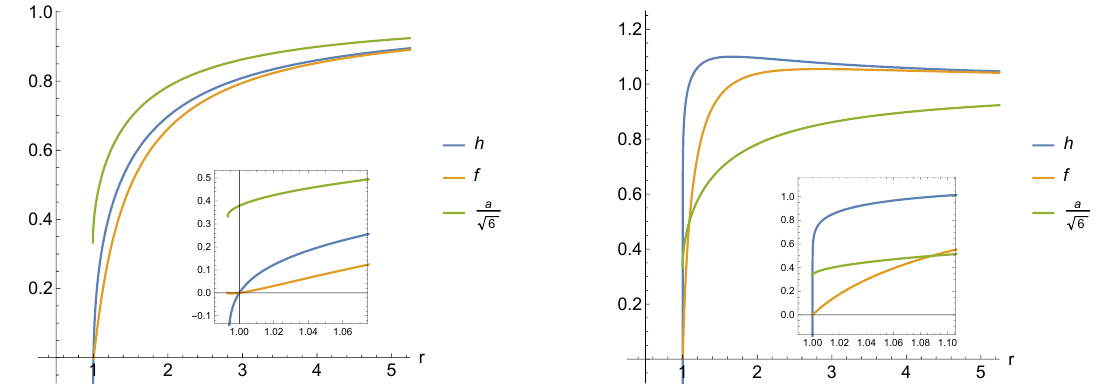
Figure 1 . Black hole solutions for (cid:22) = 0 and a) M = 0 (the left panel); b) for negative M , such that the e(cid:11)ective mass at in(cid:12)nity is negative (the right panel). (cid:13)at or adS for (cid:22) = 0 and non zero respectively. For example, expression (4.18) picks up